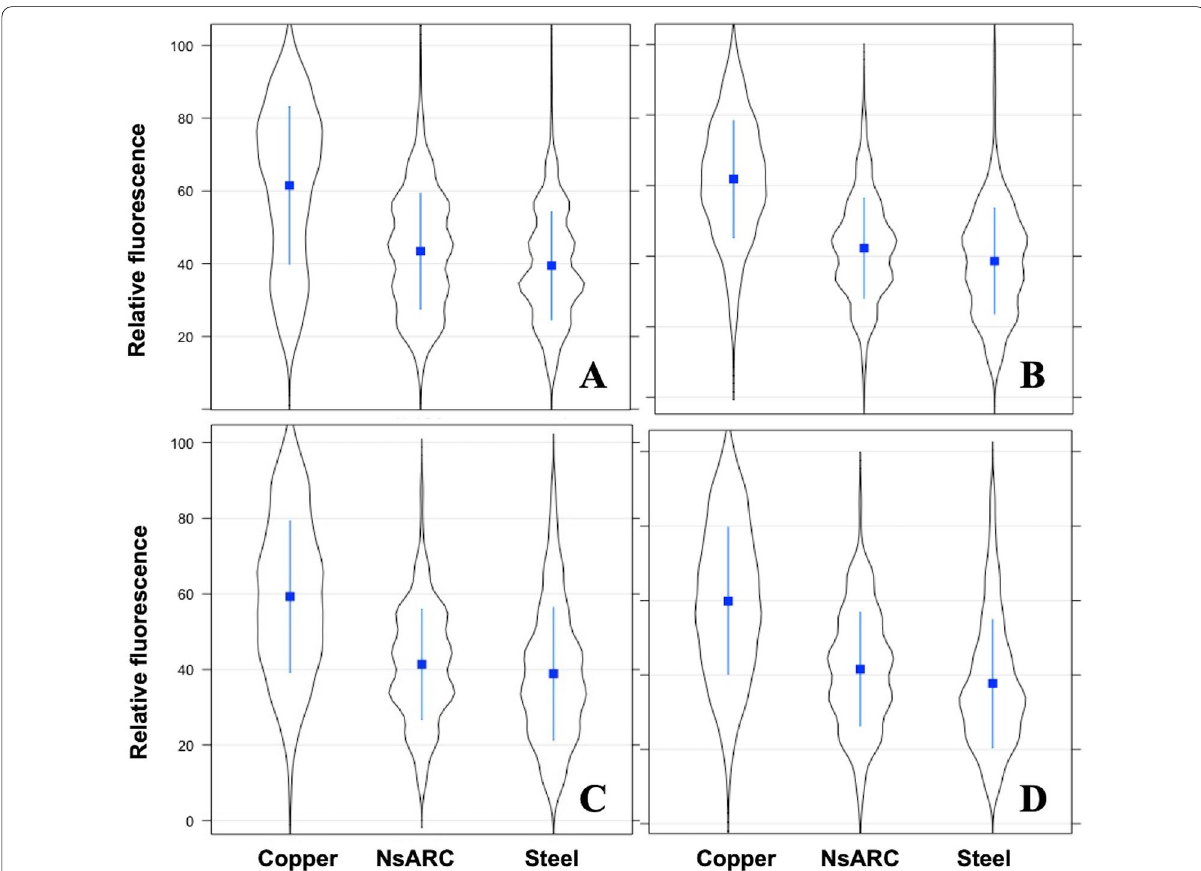
Fig. 5 Single-cell fluorescence intensity of E. coli BW25113 expressing mScarlet red fluorescent protein under the control of the soxS promoter upon exposure to copper, NsARC and stainless steel under ( A ) UV light, ( B ) visible light, ( C ) ambient light and ( D ) dark. The violin plots show the distribution of the single-cell fluorescence within the cell population. The bar in the box depicts the median and the box shows the 25% and 75%